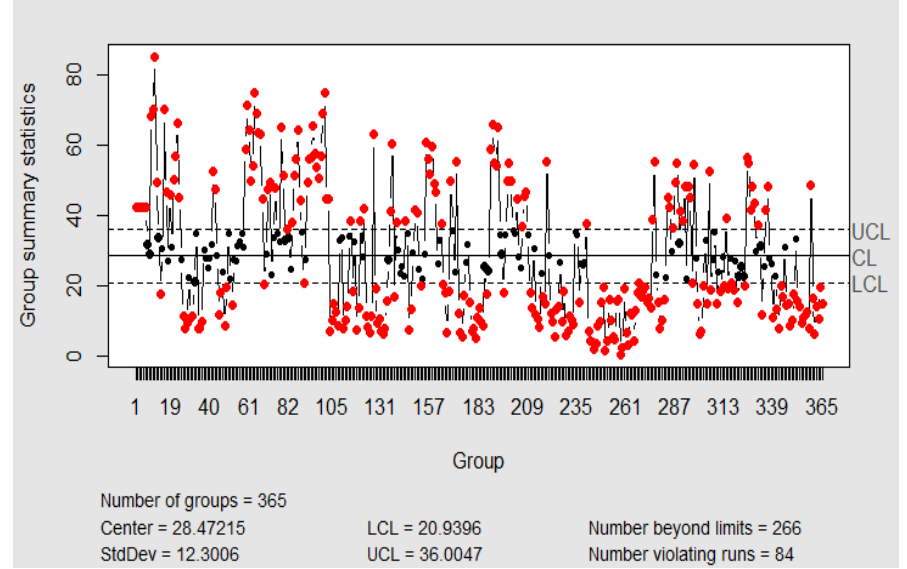
Figure 8. Xbar-chart of hourly NO 2 concentrations with the daily rational subgroup of data. Software: R-programming